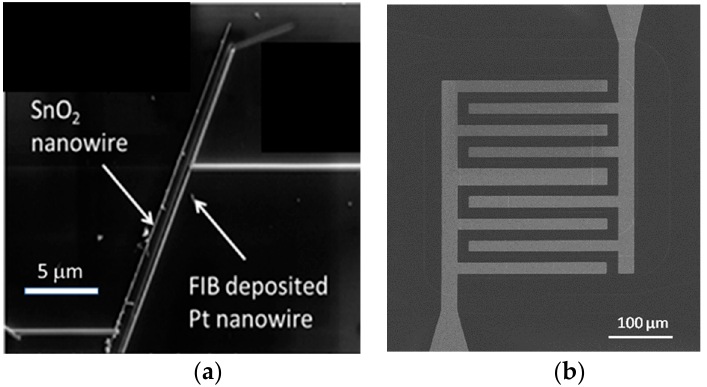
Figure 9. ( a ) Microscopy image of the surface of an oxidized silicon wafer with a pair of parallel nanowire-electrodes placed on top. Reproduced with permission from [11]. Copyright Royal Society of Chemistry, 2011; [13]. Copyright Elsevier, 2013; ( b ) Microscopy image of the surface of a MEMS micro-heater chip featuring a pair of interdigital Pt electrodes. Reproduced with permission from [12]. Copyright Elsevier, 2013.